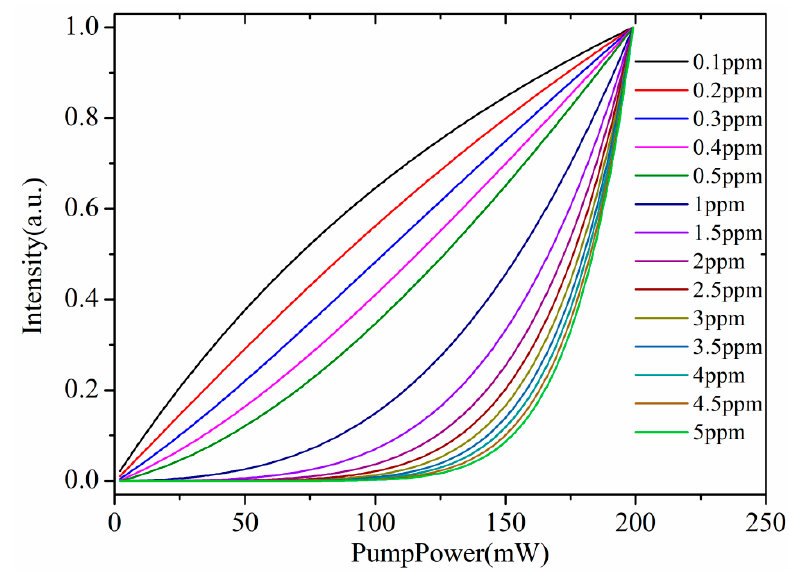
Figure 14. The ASE intensity of 20 cm-long QDs-doped POFs as function of pump powers with concentrations of 0.1 ppm–5 ppm.